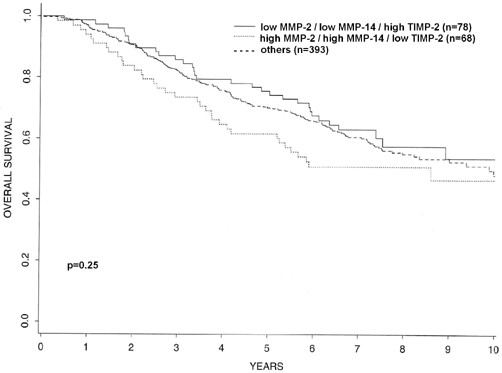
Overall survival curves for: matrix metalloproteinase (MMP)-2, MMP-14 and stromal tissue inhibitor of metalloproteases (TIMP)-2 (p values obtained by the log-rank test).